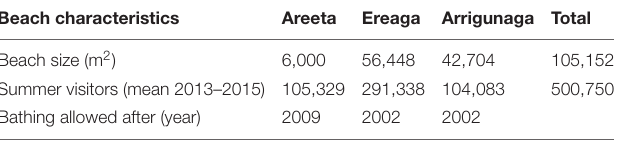
TABLE 2 | Main characteristics of the